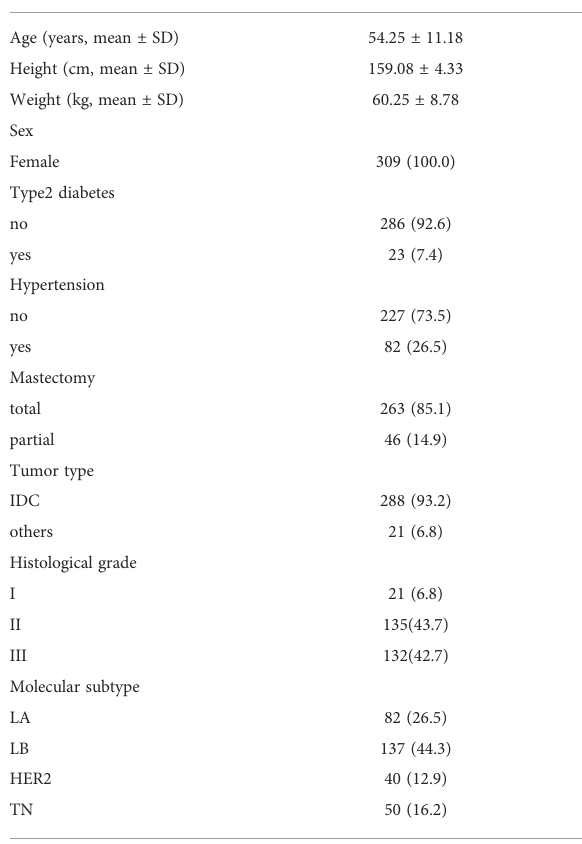
TABLE 1 General characteristics of patients with breast